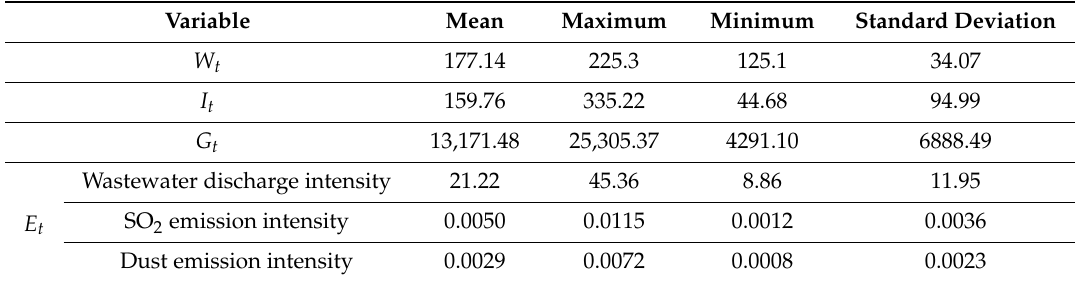
Table 1. The statistical summary of all variables in this research.